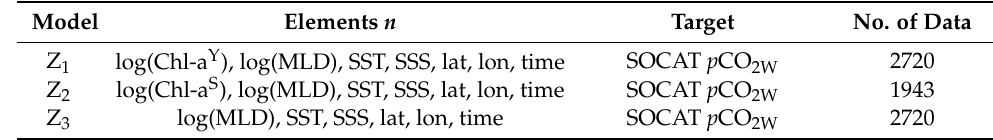
Table 2. Input and target vector elements for each dataset used in our network: Chl-a Y is chlorophyll- a concentrations through the year, Chl-a S is seasonal chlorophyll-a concentrations, MLD is the upper ocean mixed layer depth, SST is sea surface temperature, and SSS is